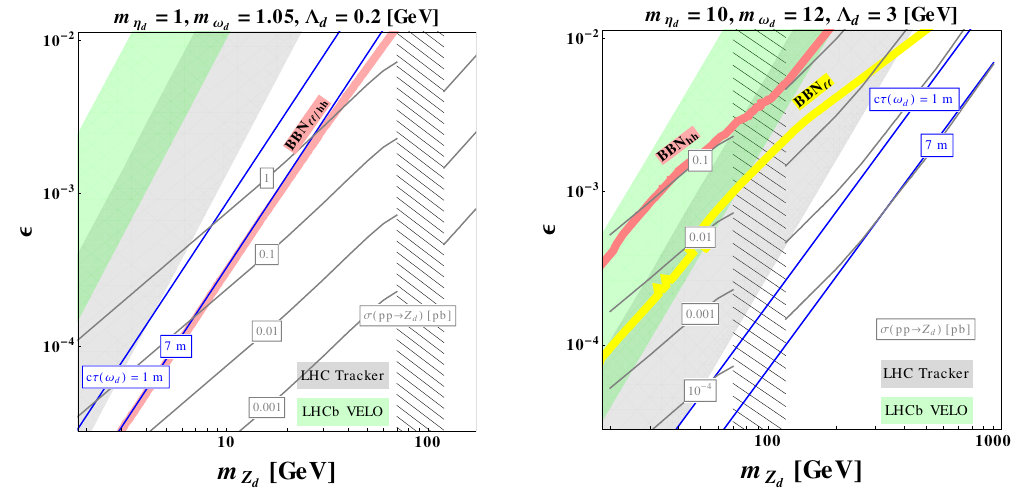
Figure 7 . Similar to (cid:12)gure 6 but with a di(cid:11)erent ! d production process, pp ! Z d ! ! d +MET. The BBN bounds favor the parameter space in the upper left corner, which gives the right decay length and larger Z d production for the LHCb and ATLAS/CMS searches using tracker detectors. We do not show the dark meson production near the Z peak (hatched